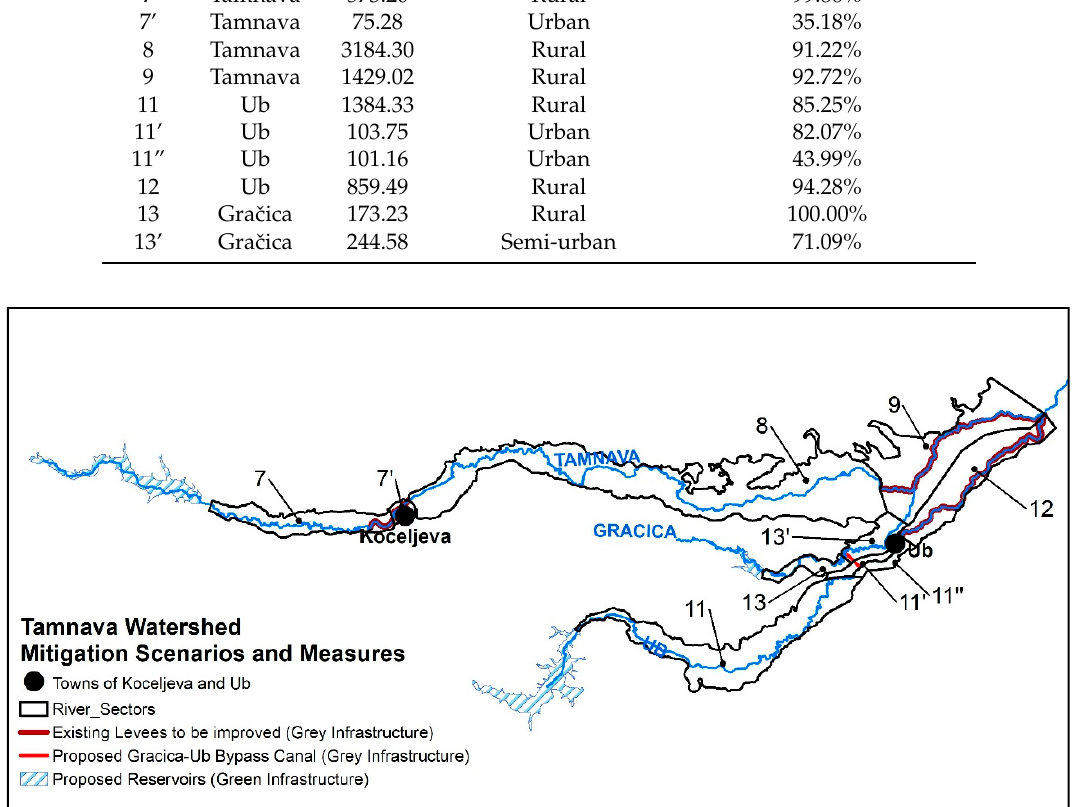
Figure 3. Division of the Tamnava, Ub, and Gra č ica rivers into river sectors. Figure also shows locations of levees and planned detention basins.